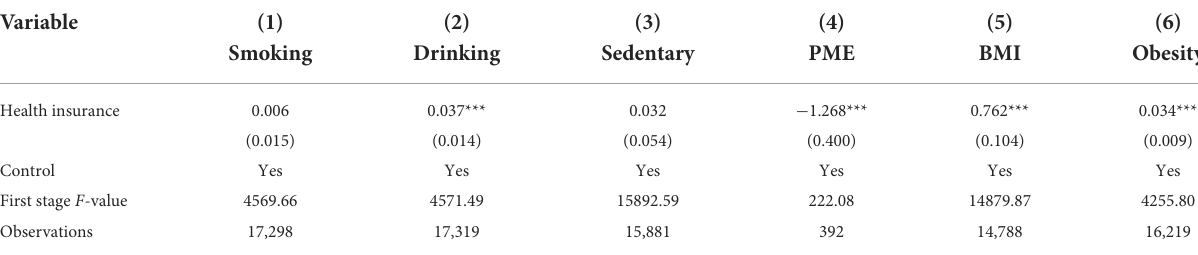
TABLE 8 Robustness check 1.